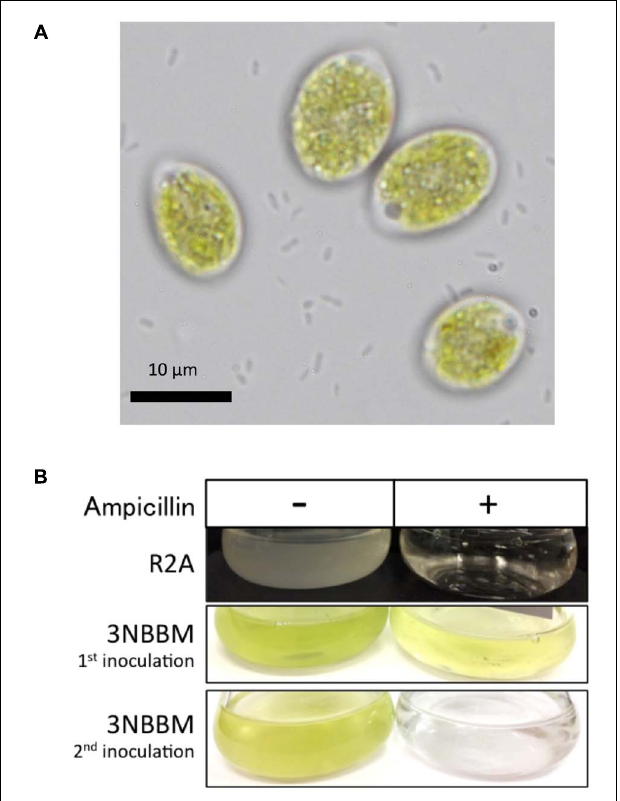
FIGURE 7 | Bacteria co-isolate with Chloromonas sp. AsaC1. (A) Microscopy shows the presence of free-living bacteria with the algae culture. Scale bar represents 10 µ m. (B) Bacteria can be cultured without the presence of algae in the dark in R2A media, but is unable to grow under 100 µ g ml − 1 ampicillin treatment. Elimination of bacteria with ampicillin hinders sustained algal